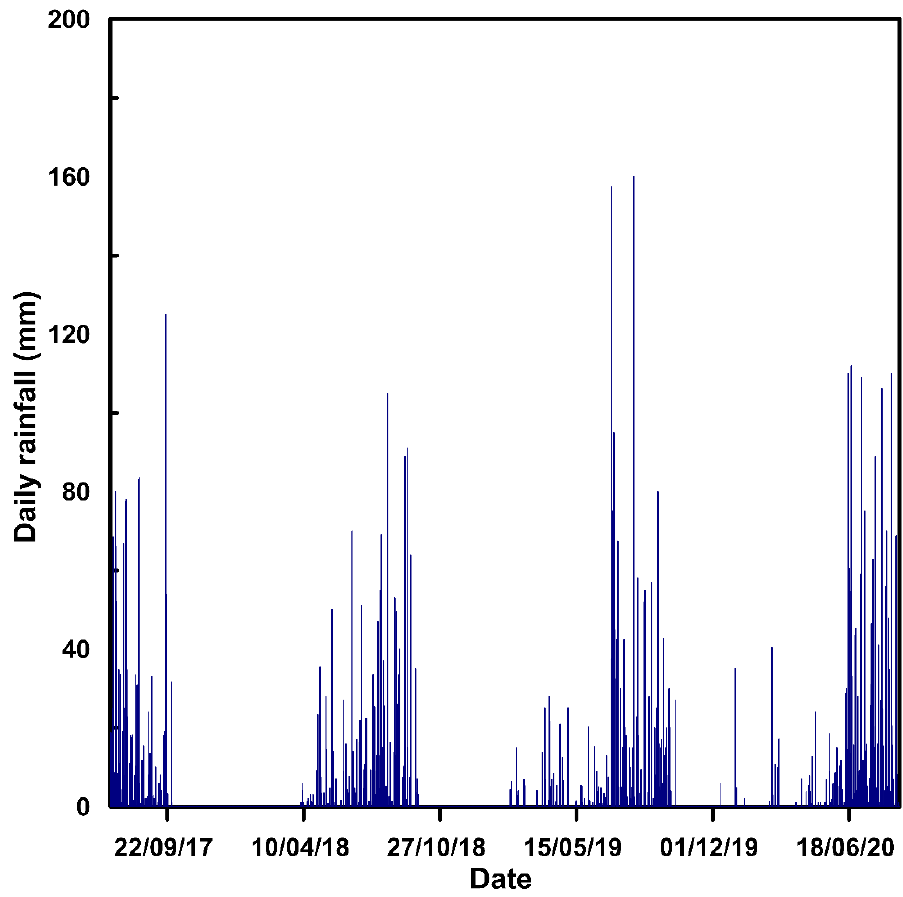
Figure 2. Daily rainfall data for Kalimpong (July 2017–August 2020).